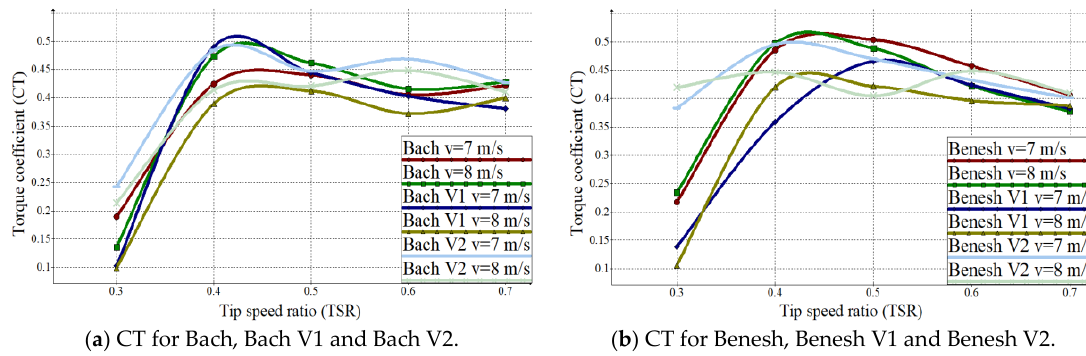
Figure 12. Torque coefficient (CT) for analyzed rotor models.